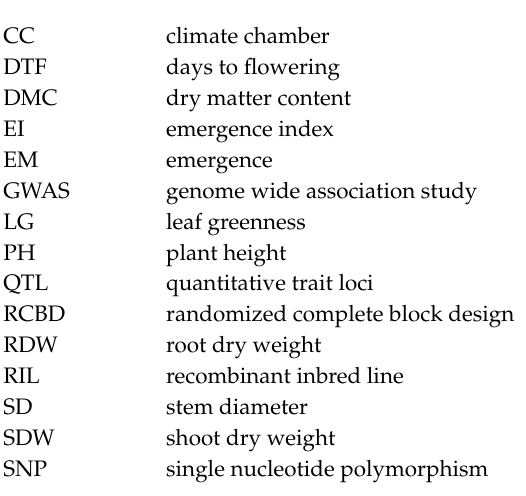
Figure S2: Manhattan plot showing p values and marker–trait associations for DMC, DMC_GG and DMC_RH. Blue horizontal line indicate threshold for significant marker–trait associations ( p < 1 × 10 − 3 )., Figure S3: Manhattan plot showing p values and marker-trait associations for DTF, DTF_GG, DTF_RH and DTF_PL. Blue horizontal line indicate threshold for significant marker–trait associations ( p < 1 × 10 − 3